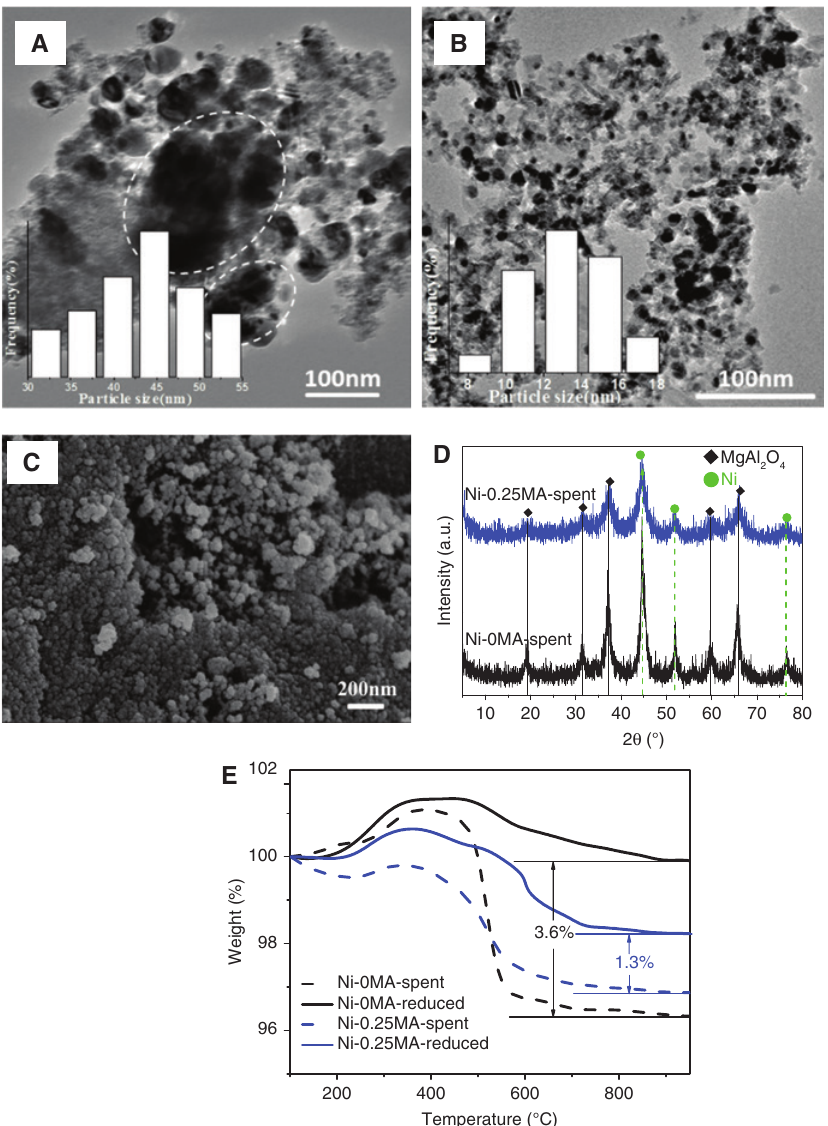
Figure 11: TEM images of the Ni-0MA-spent catalyst (A) and Ni-0.25MA-spent (B); SEM image of the Ni-0.25MA-spent catalyst (C); XRD analy- sis of the Ni-0MA-spent and Ni-0.25MA-spent (D); and TG curves of the reduced and spent catalysts in air (E). Particle statistical distribution images ofNi-0MA-spent and Ni-0.25MA-spent are listed in (A) and (B)